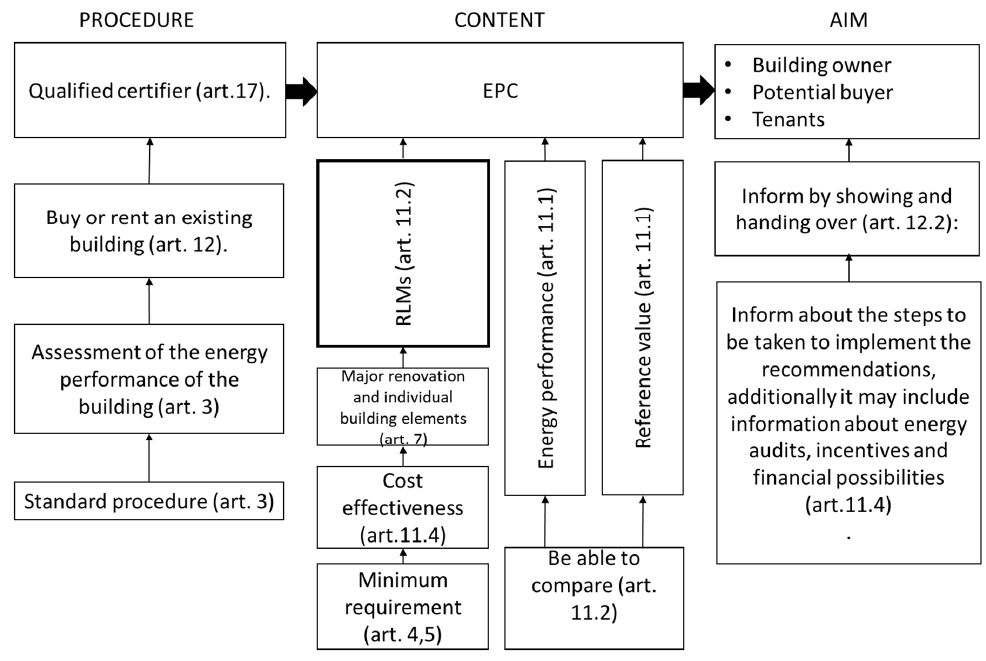
Figure 1. General scheme of the EPC and RLMs requirements.